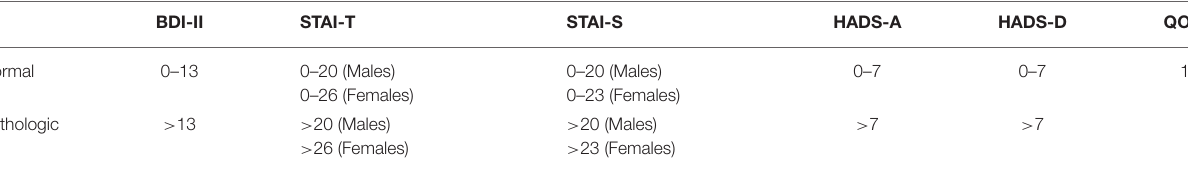
TABLE 1 | Cutoff points of the inventory